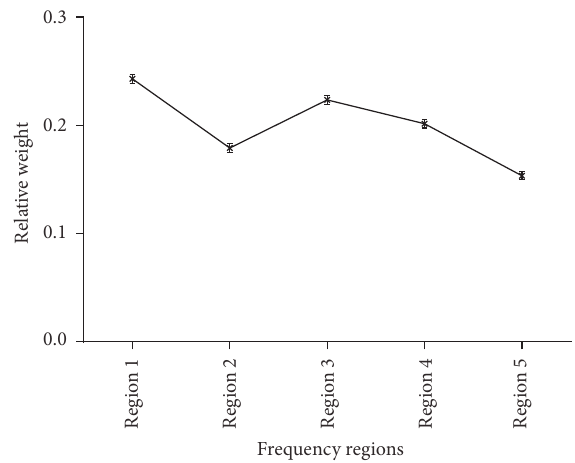
Figure 3: The relative weights of different frequency regions for Mandarin sentence recognition using acoustic temporal envelope. The error bars indicate standard